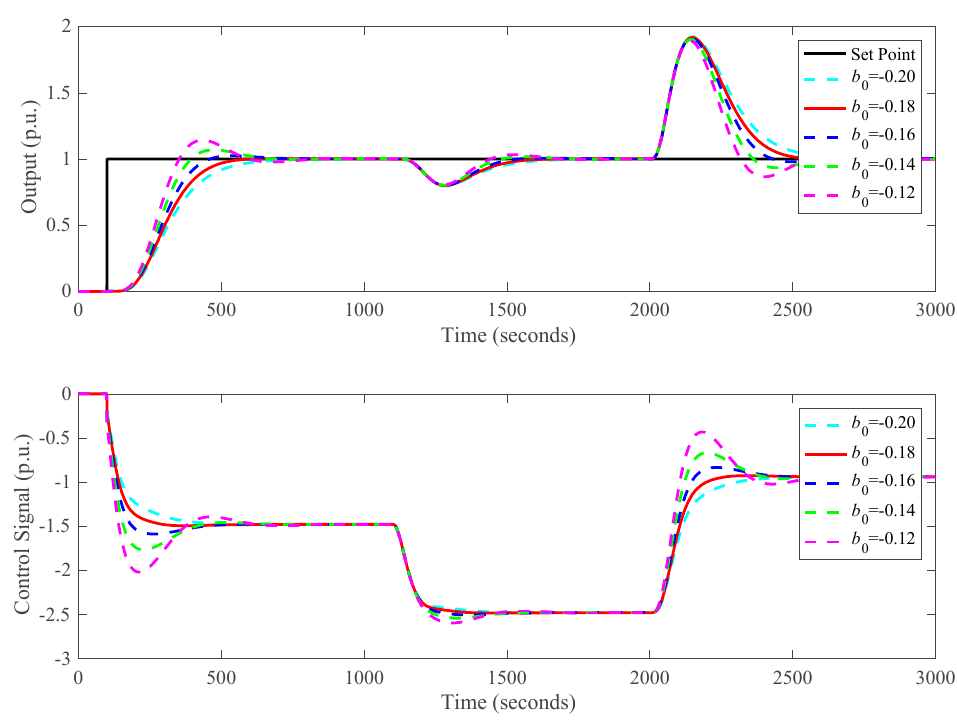
Figure 11. The influences on control performance with di ff erent b 0 .